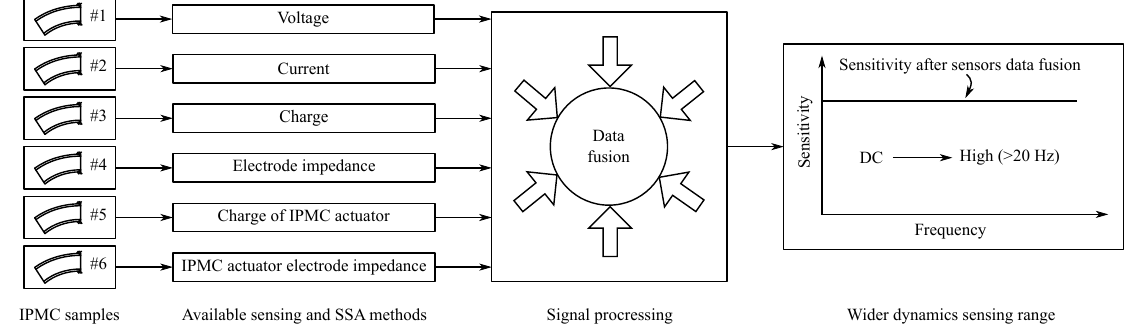
Figure 23. Combining sensing signals from multiple IPMC sensing methods. Individual sensing methods work reliably within their limited frequency ranges, and combining two or more methods would result in an improved deformation estimation